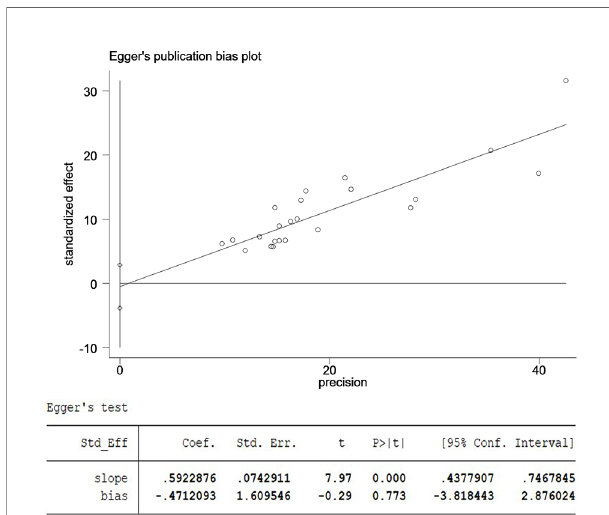
FIGURE 3 | The publication bias of the study was evaluated by funnel chart and Egger ’ s test. CI, con fi dence interval; SND, standard normal deviation.